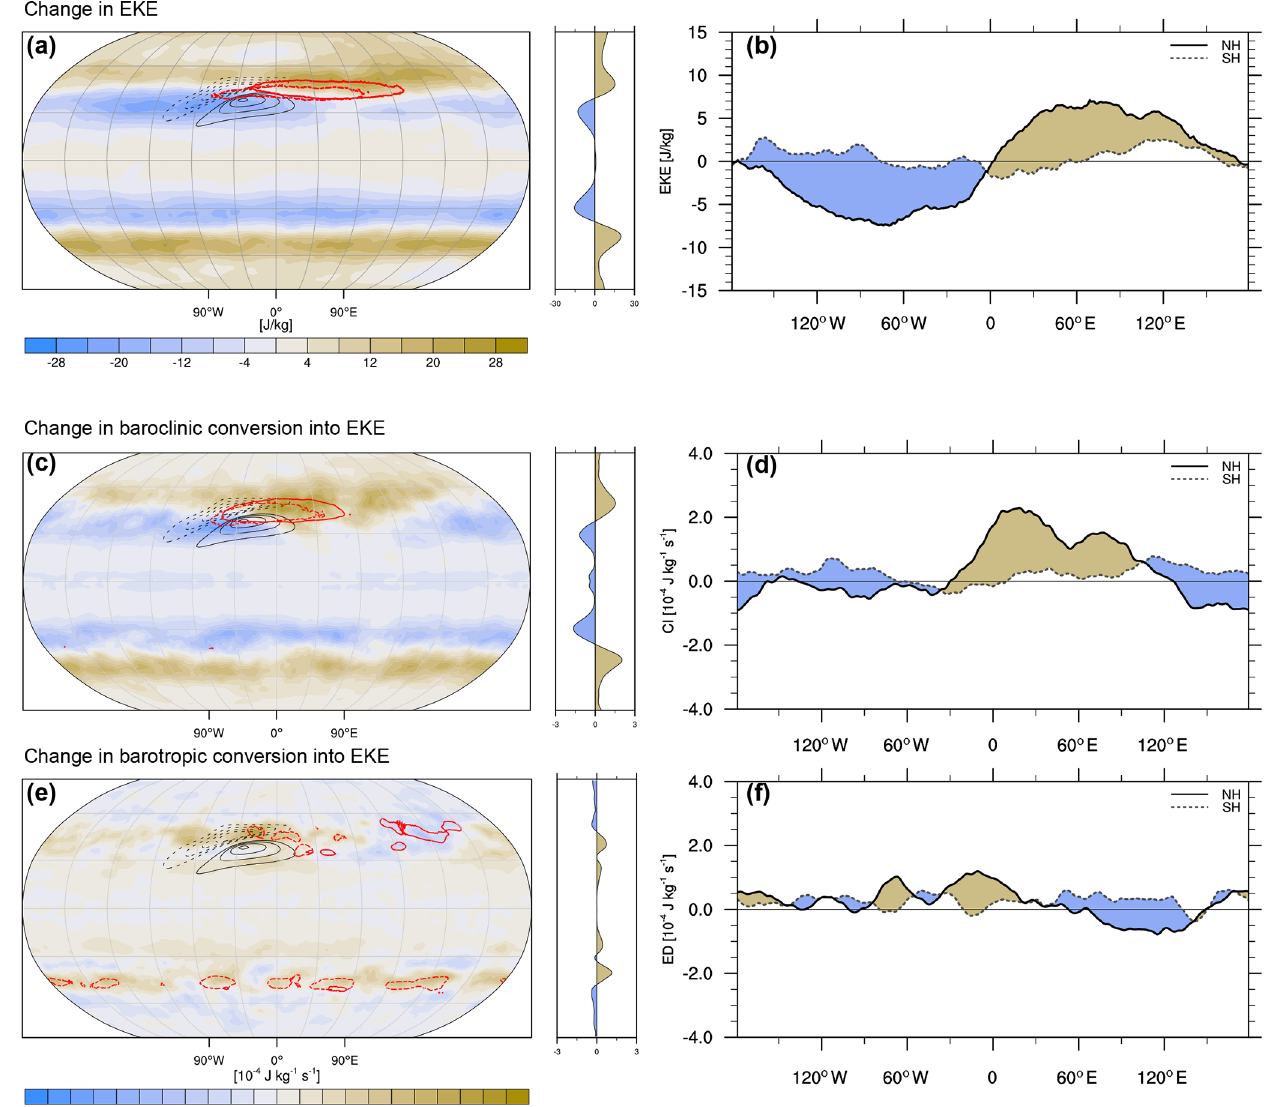
Figure 6. (a) EKE difference between warmed and control simulations (mass-weighted vertically averaged between 1000–200hPa). Ad- ditional red contours indicate the selected EKE value of 135Jkg − 1 in the control (red dashed) and warmed (red solid) simulations; black contours indicate the SST front. (c) Change in internal baroclinic and (e) barotropic generation rates of EKE. Additional red contours in (c) indicate 12 × 10 − 4 J(kgs) − 1 in the control (red dashed) and warmed (red solid) simulations and in (e) indicate − 3 × 10 − 4 J(kgs) − 1 (note that the time-mean barotropic conversion is mostly negative). (b) EKE difference between the warmed and control simulations but merid- ionally averaged over the Northern Hemisphere (solid) and Southern Hemisphere (dashed) midlatitudes (20–60 ◦ ). Color shading highlights differences between the two hemispheres. (d, f) As (b) but for baroclinic and barotropic EKE